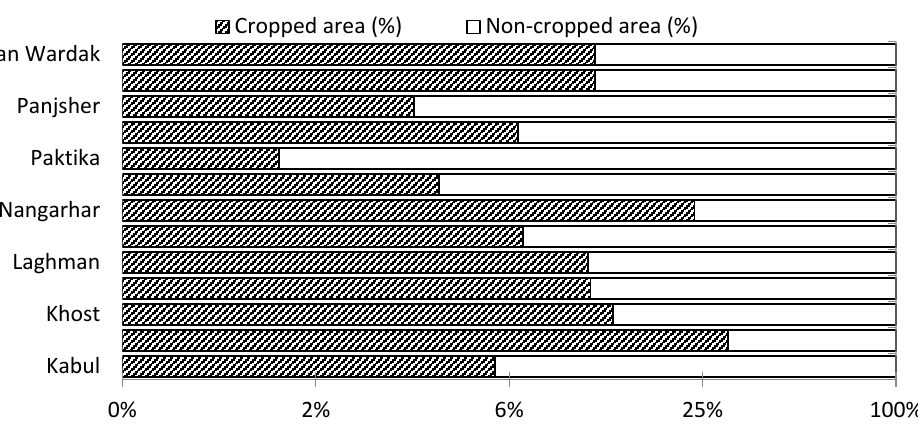
Figure 8. Physical distribution of cropped and non-cropped area of the KRB.